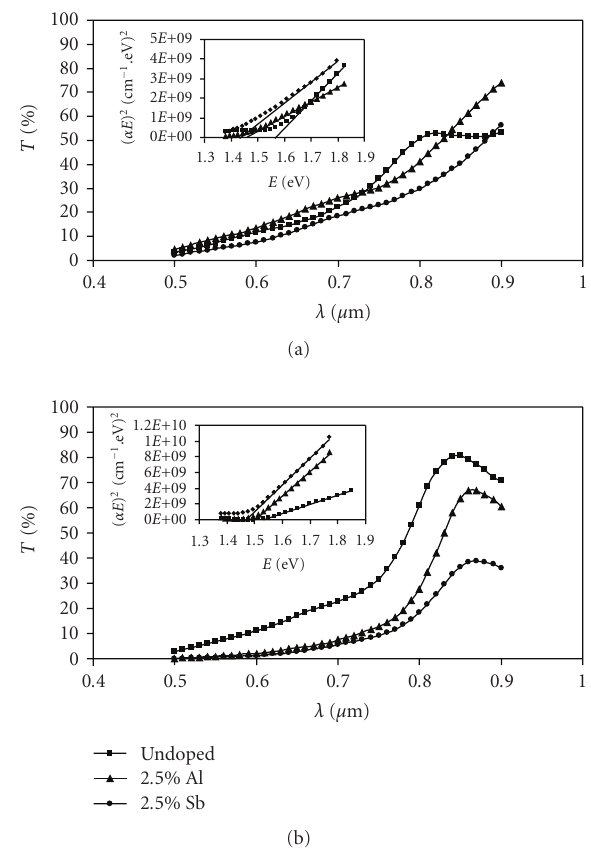
Figure 1: (a), (b) Transmission spectra of undoped and doped CdTe thin films with 2.5% Al and 2.5% Sb deposited on glass substrate at (a) RT and (b) 423 K. The inset shows ( αE ) 2 versus E